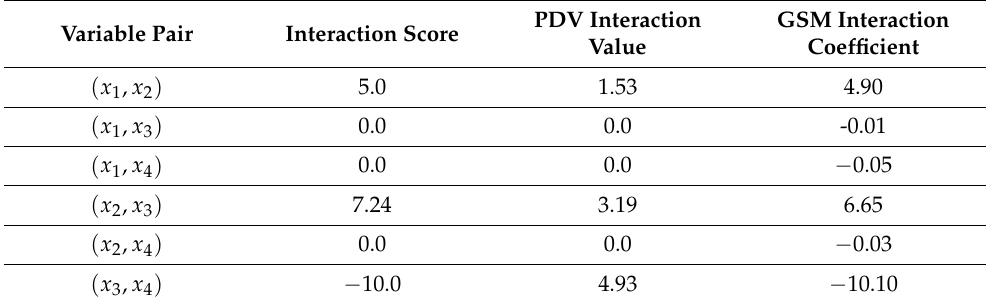
Table 4. The interaction scores, PDV interaction values and GSM interaction coefficients applied to the true relationship underlying Simulation Data #2 for all six variable pairs. Variable Pair Interaction Score